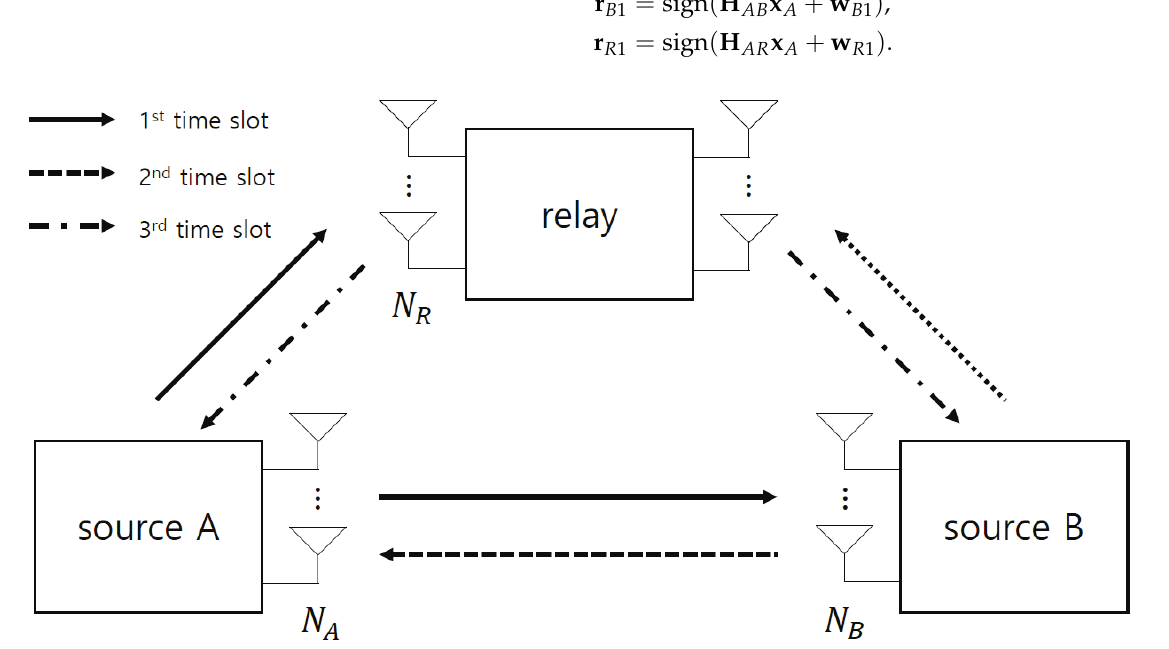
Figure 4. DF protocol for two-way